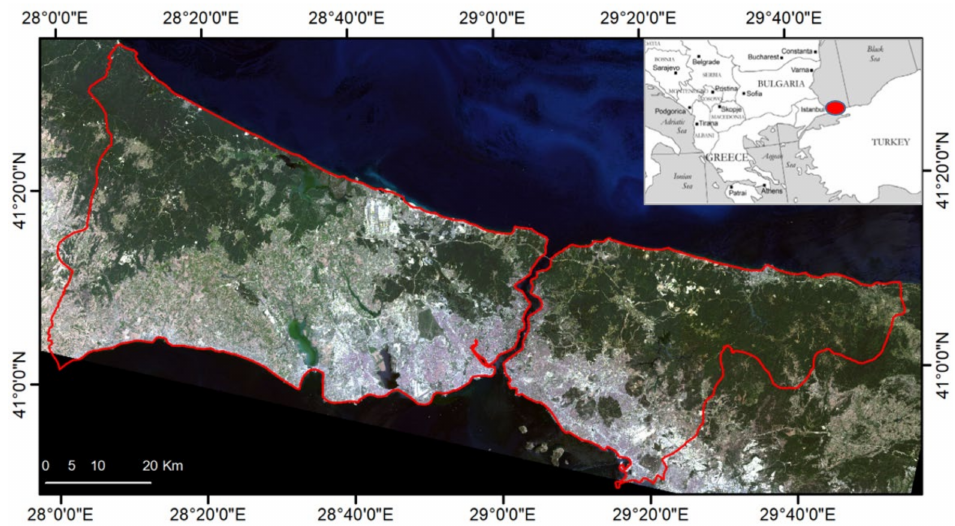
Figure 1. Study area on Landsat 8 OLI true color image (RGB:432) dated 23 July 2022,